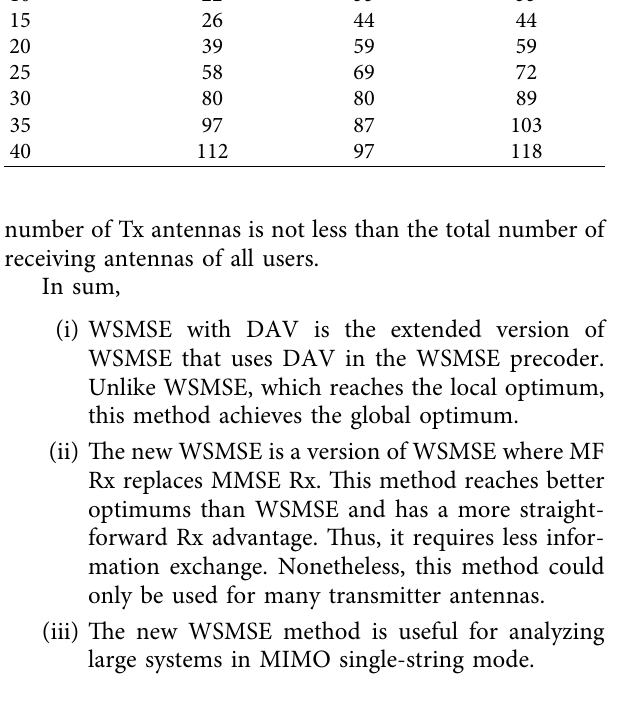
Table 2: Simulation parameters and results of Figure 6. C �